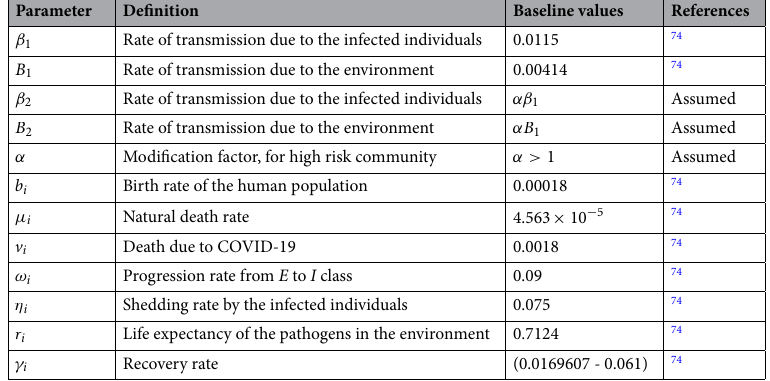
Table 1. Model parameters and their baseline values. The time unit is a day.